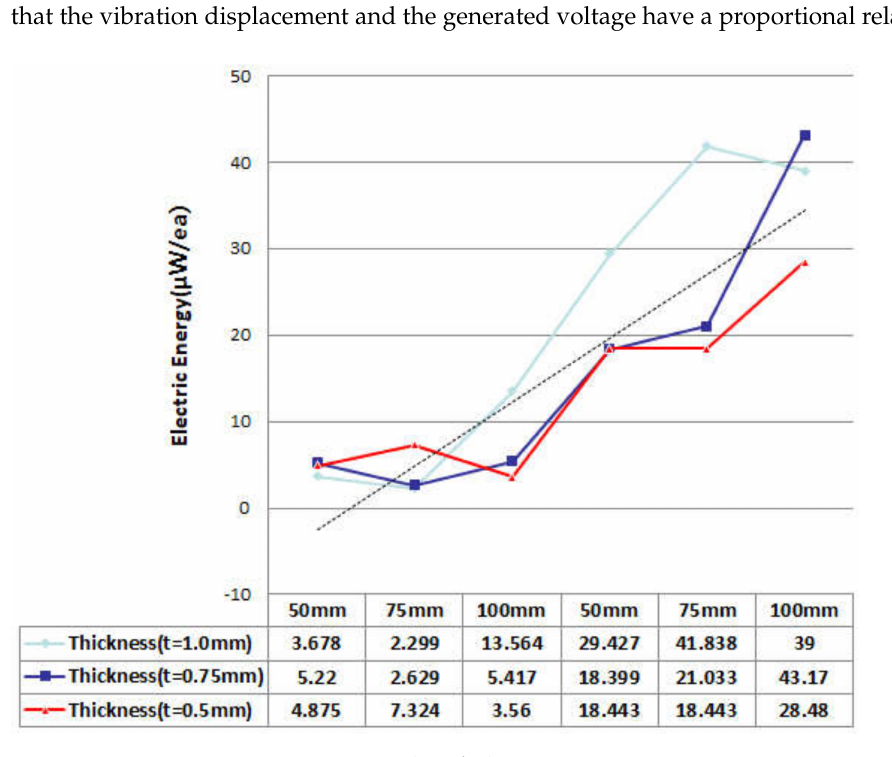
Figure 10. Power generation estimation ( µ